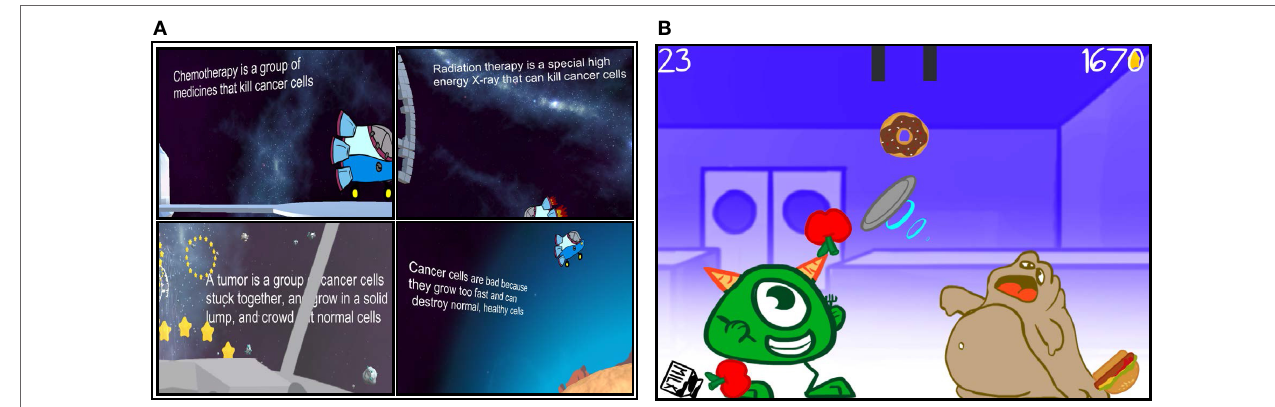
FigUre 7 | Educational empowerment is facilitated by (a) important on-screen health-related messages interspersed through the game and (B) mini-games that center on teaching important components of cancer patient care, like nutrition, that are preceded by simple graphic gameplay